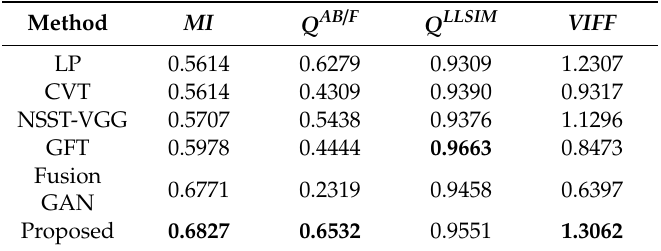
Table 1. Mean values of Quality metric for di ff erent methods with 16 cell images.